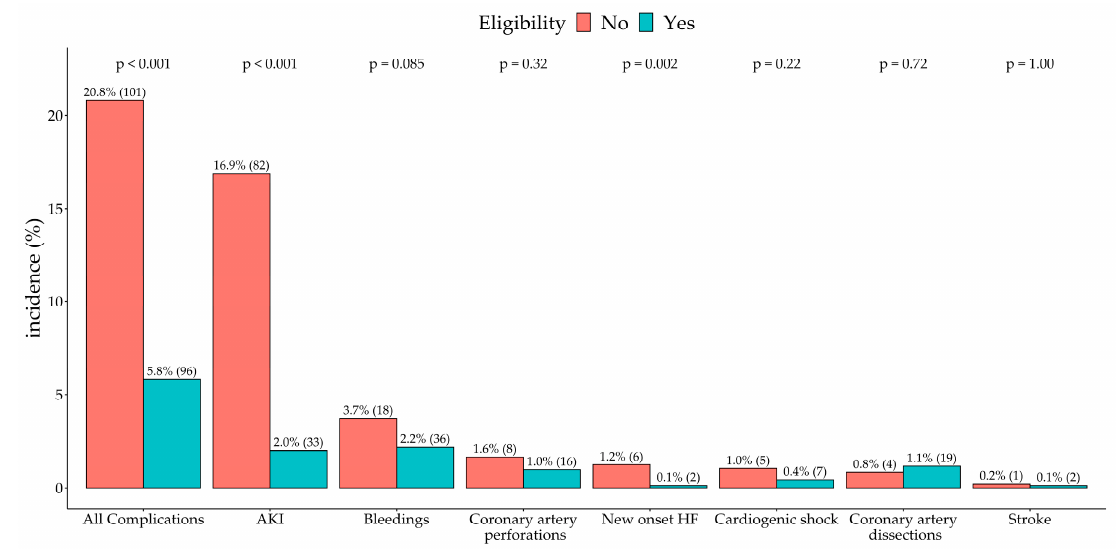
Figure 3. The periprocedural complications in JCD–KiCS. Abbreviations: AKI, acute kidney disease; HF, heart failure. HF, heart failure.